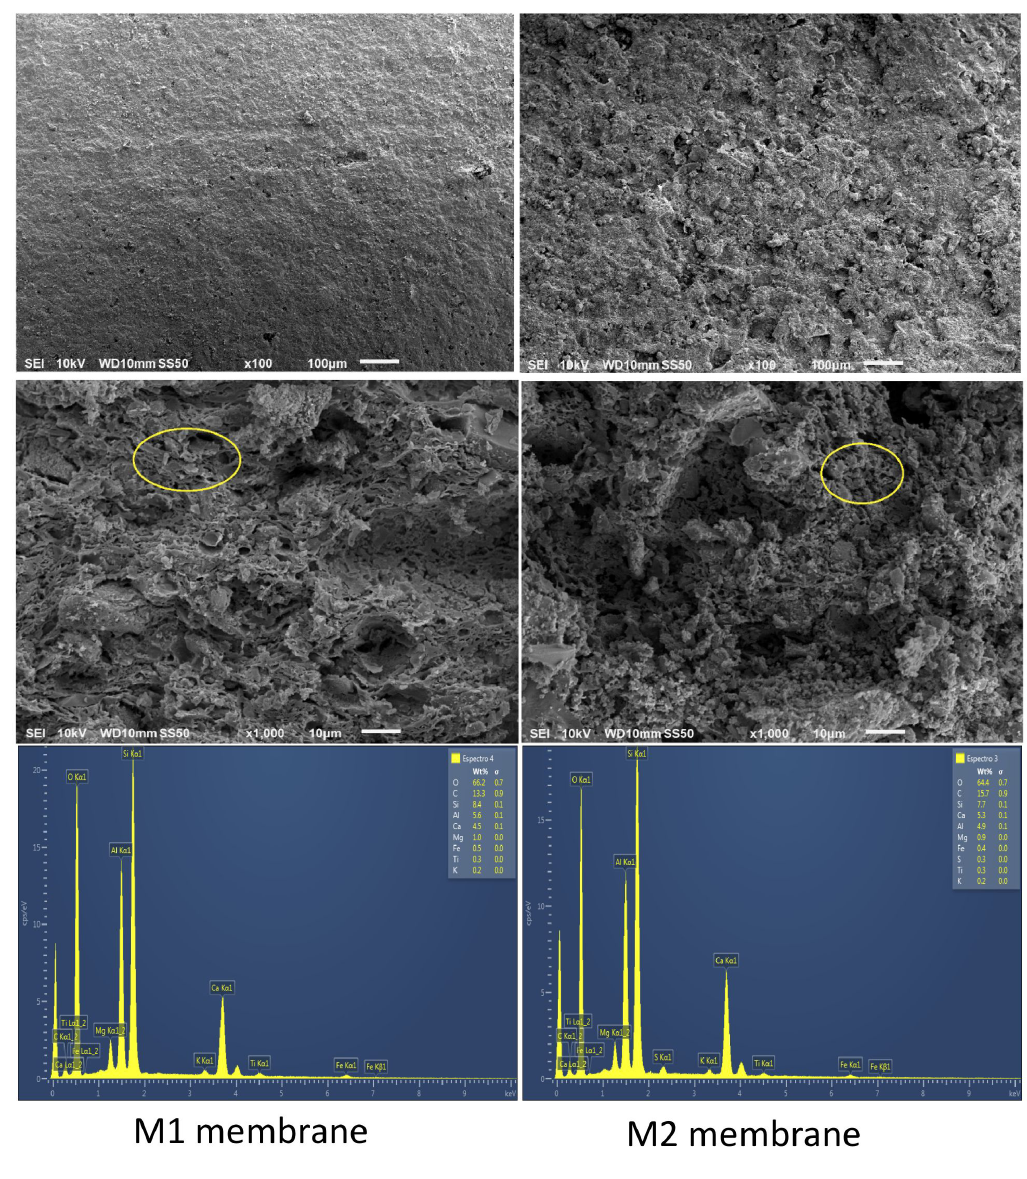
Figure 2. SEM micrographs and EDS of M1 and M2